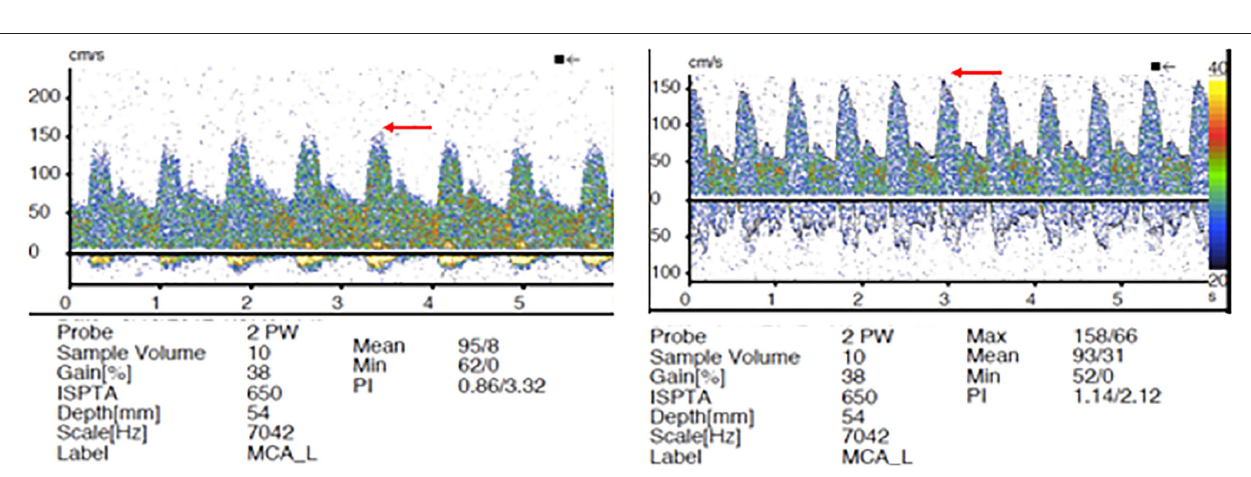
FIGURE 3 | Transcranial doppler (TCD) pre- and post-FD. Elevation of pulsatility indices (PIs) post-FD device placement with more spiked appearance in the peak systolic waves (red arrows).